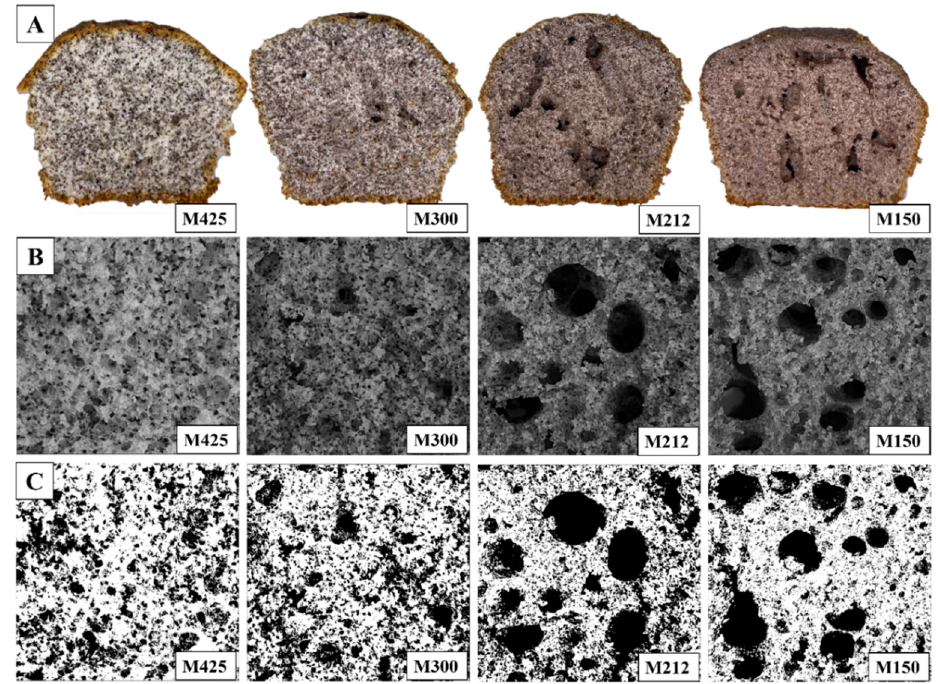
Figure 3. Pictures of transversal section of muffin prepared with different particle sizes: ( A ); longitudinal section of muffin crumb ( B ); binary images of muffin crumb ( C ). M425, muffin with addition of grape pomace powder at 600–425 μ m; M300, muffin with addition of grape pomace at 425–300 µ